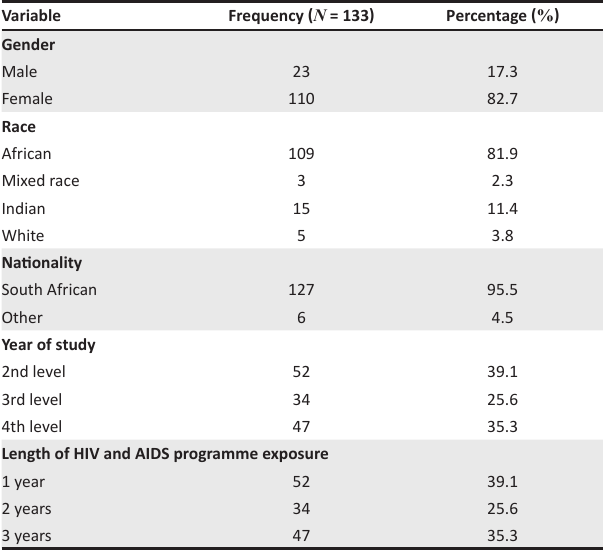
TABLE 2: Demographic profile of